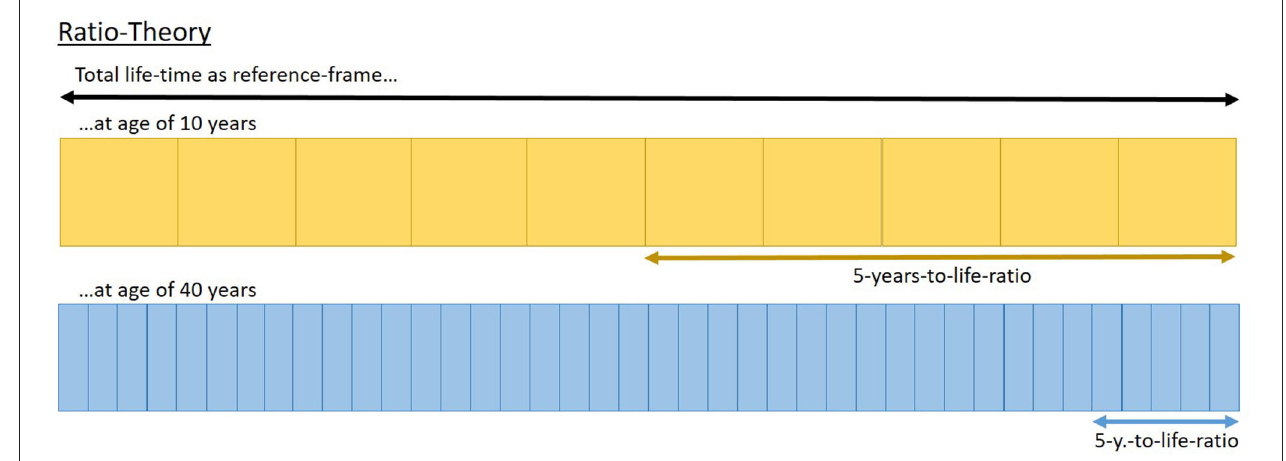
FIGURE 1 | Illustration of ratio-theory suggesting that perception of time-units is affected by the relative length of these units compared to life-time. This depicts that an interval of 5 years covers 50% of the life-time from a 10 year old person but only 12.5% of the life-time from a 40 year old